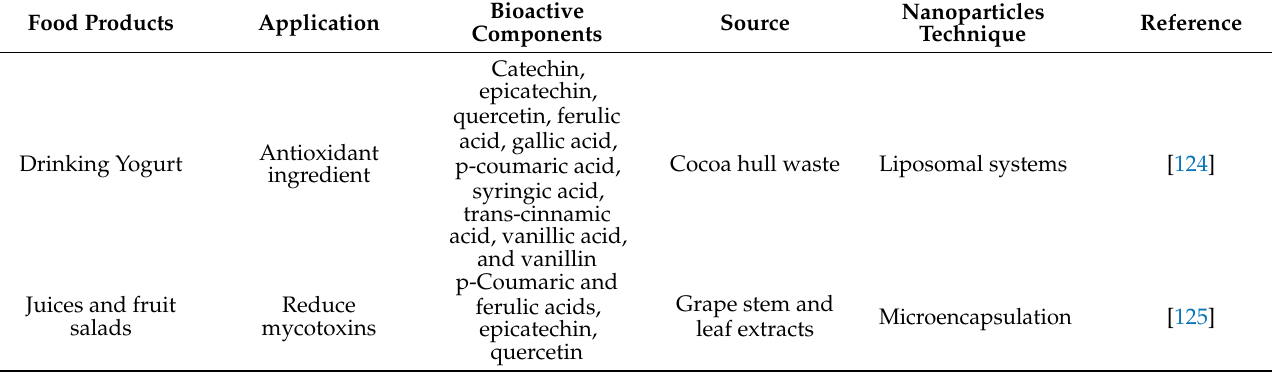
Table 4. Nanoencapsulation applied to bioactive compounds recovered from agro-food wastes with the purpose to be reintroduced in food chain.